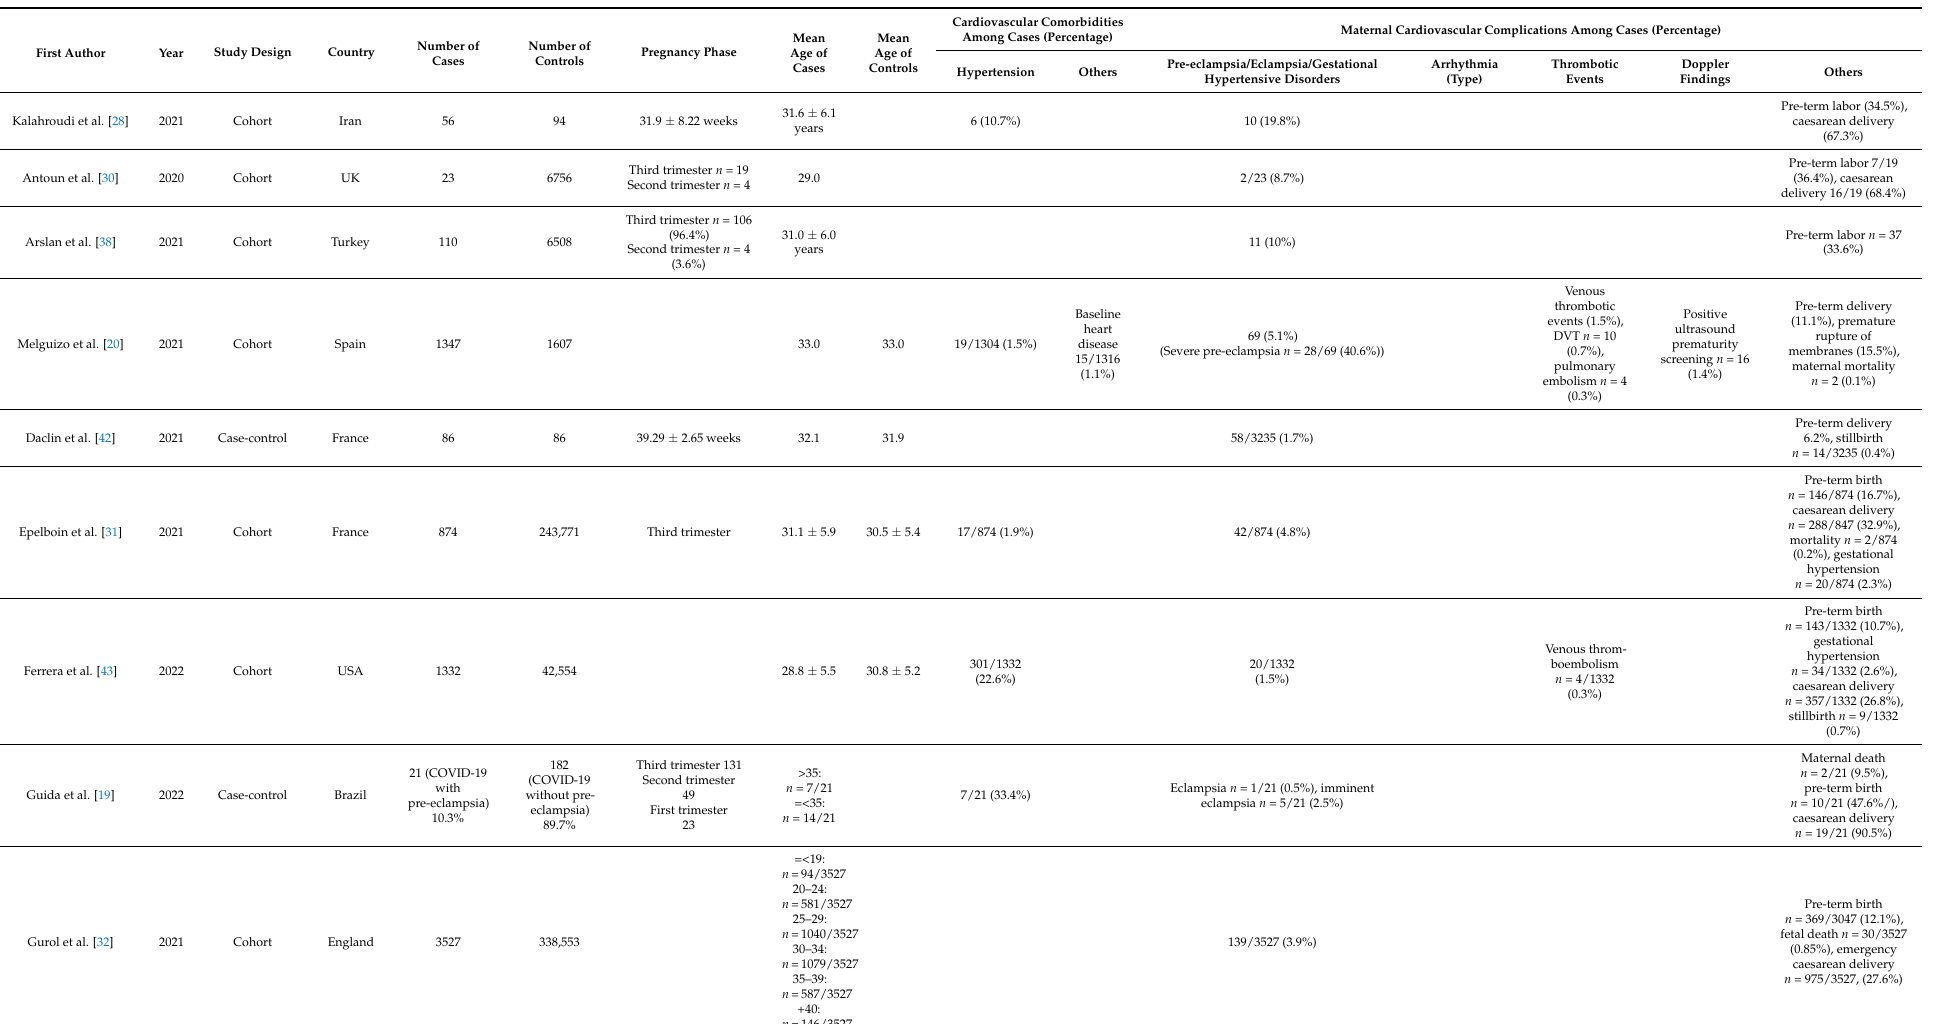
Table 1. Characteristics and maternal outcomes of the included cohort/cross-sectional/case-control